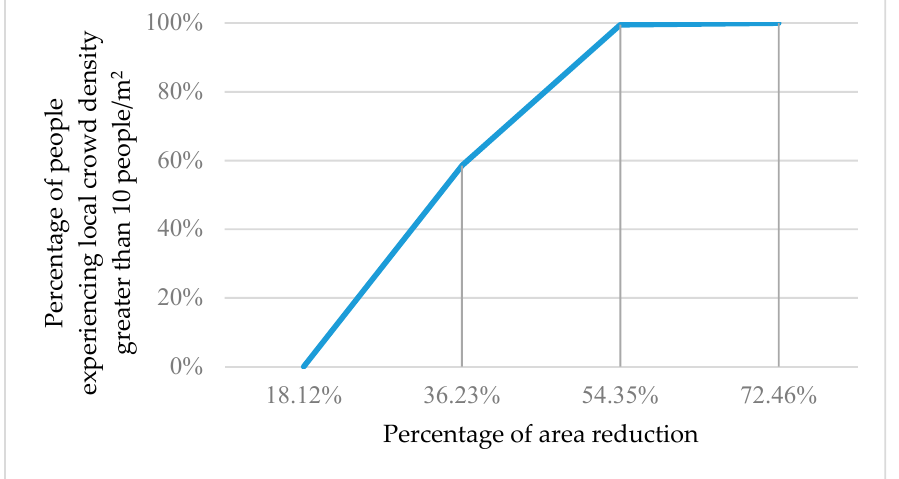
Figure 7. The percentage of 200 people experiencing local crowd density greater than 10 people/m 2 as the occupied area shrinks.